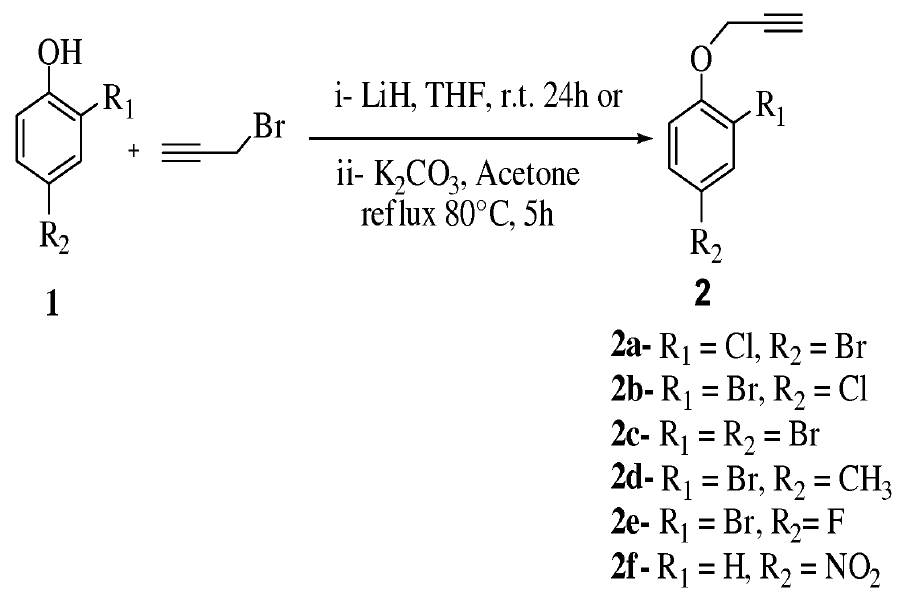
Fig. 1. Synthesis of compounds 2a–f.